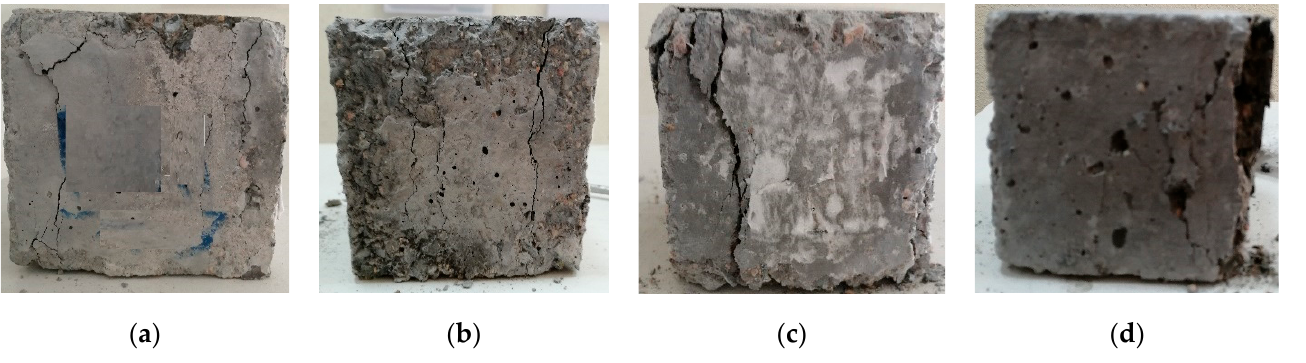
Figure 9. Compressive failure for tested cubes at 7, 28, and 56 days: ( a ) M7 at 7 days; ( b ) M9 at 7 days; ( c ) M9 at 28 days; ( d ) M9 at 56 days.